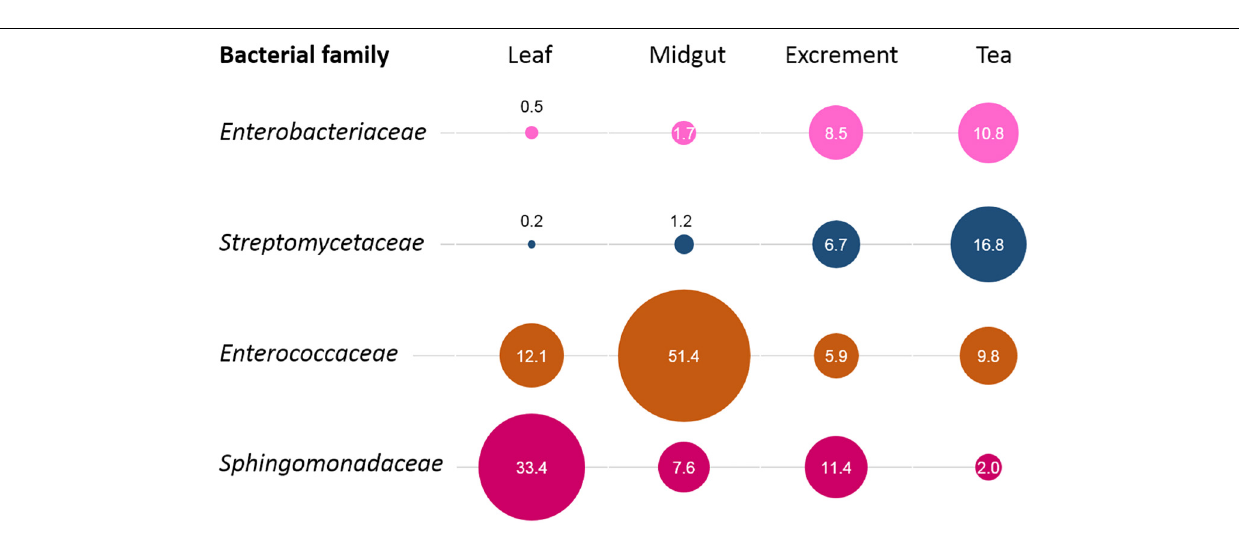
FIGURE 5 | Process-step-specific enrichments of distinct bacterial families. For each process step, the enrichment of distinct bacterial families was observed. The identified families were unevenly distributed among sample types and showed a clear predominance at a distinct production step. The bubble sizes correlate with their relative abundance in the respective sample type, while the numbers indicate their exact